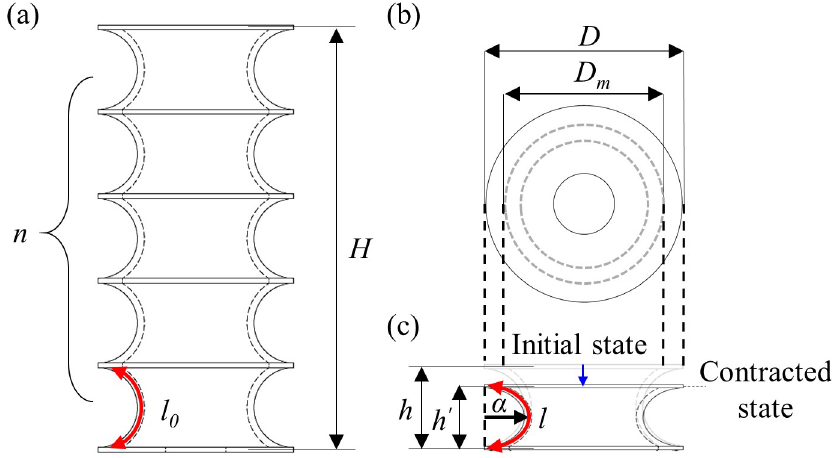
Fig 2. Design parameters: (a) a bellow structure at the initial state with null applied vacuum; (b) top view of bellow structure; (c) a single segment in the contracted state induced by vacuum.